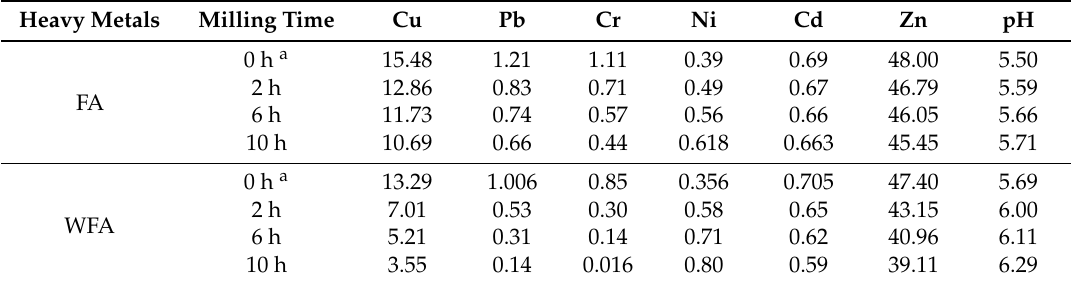
Table 3. Leaching test results after milling.